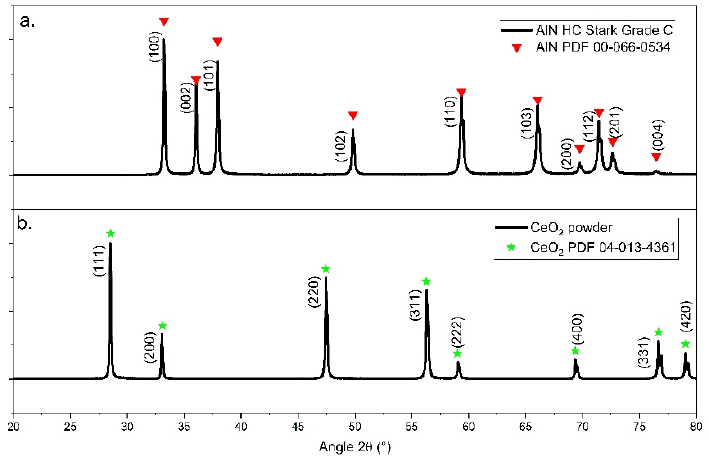
Figure 1. X-ray diffraction patterns of ( a ) aluminum nitride raw powder; ( b ) cerium oxide raw powder. Table 1. Chemical analyses of raw powders.